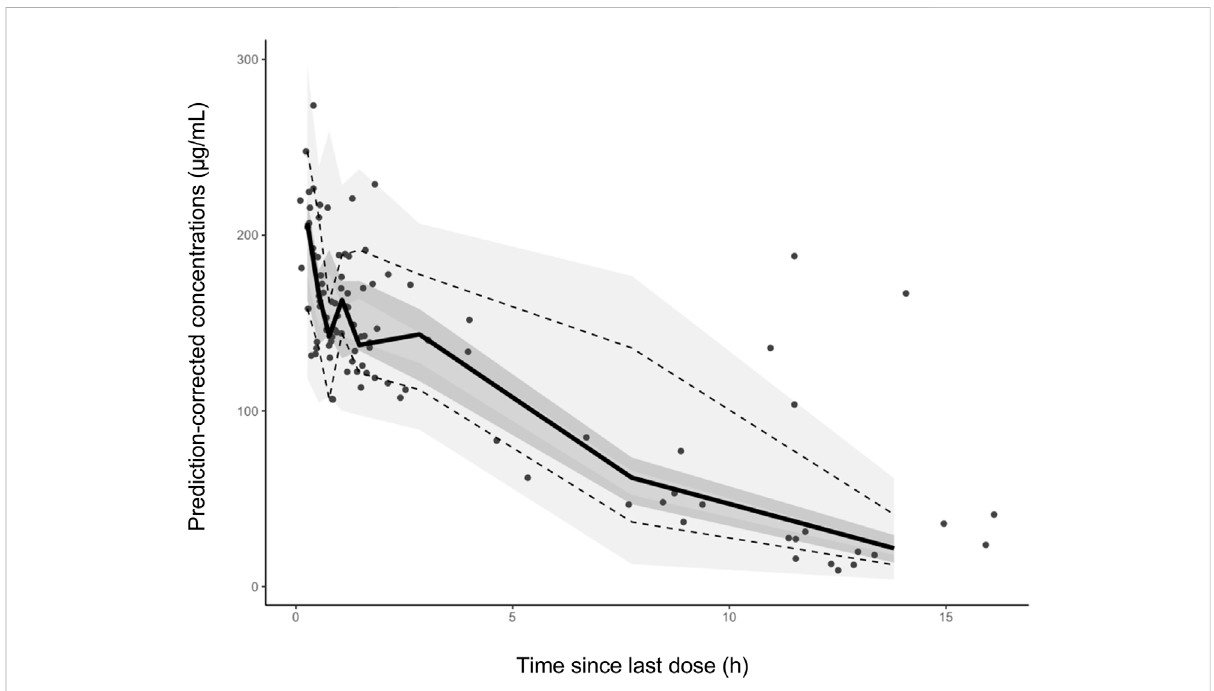
The prediction corrected visual predictive checks. The circles represent the prediction-corrected observed concentrations. The solid line represent the median prediction-corrected observed concentrations and semitransparent gray fi eld represents simulation-based 95% con fi dence intervals for the median. The observed 5th and 95th percentiles are indicated by dashed lines, and the 95% intervals for the model-predicted percentiles are in a lighter translucent